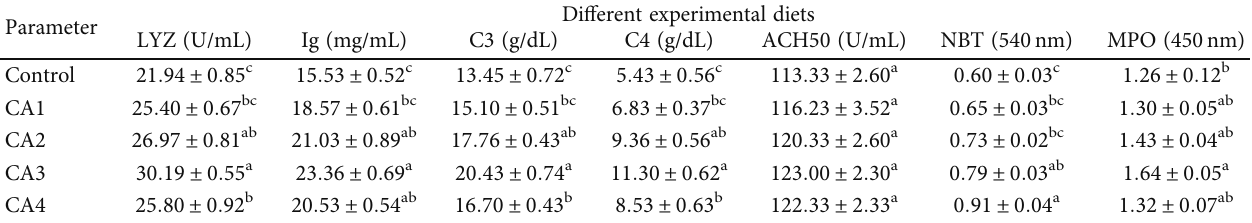
Data in a column assigned with di ff erent letters signify signi fi cant di ff erence between treatments ( P < 0 : 05 ). Values are presented as mean ± SE . LYZ: lysozyme; Ig: total immunoglobulin; C3 and C4: complement components 3 and 4; ACH50: alternative complement activity; NBT: nitroblue